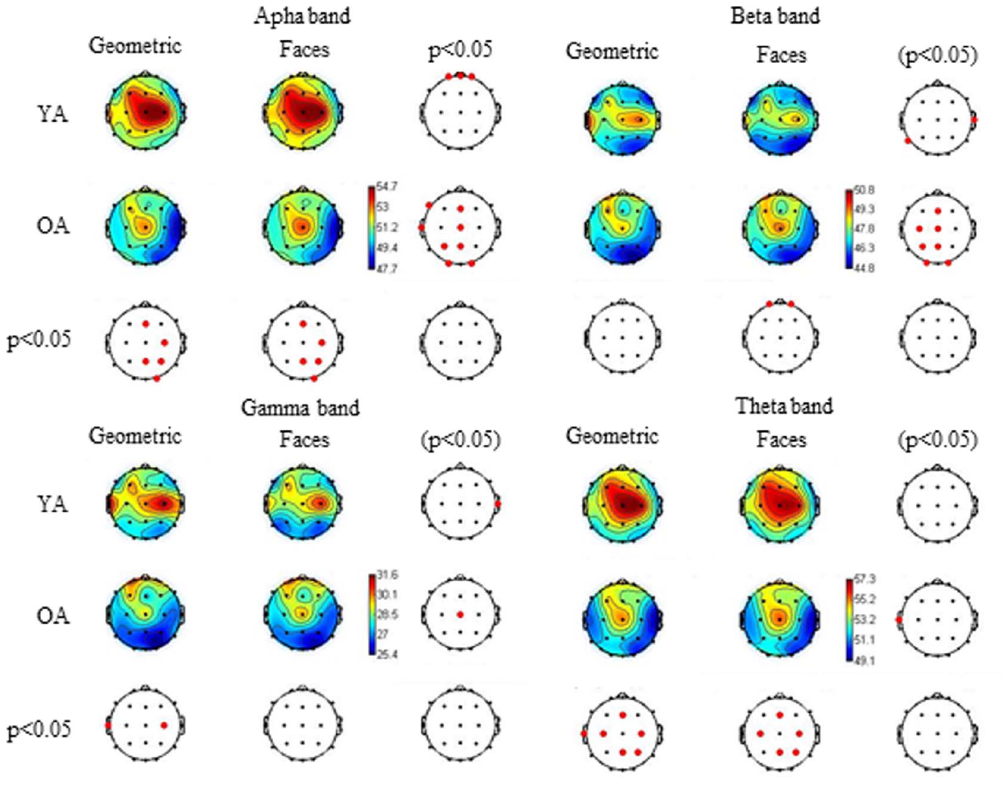
Figure 3. Relative topographic power spectrum distribution for specific bands with type of stimulus and age group. Types of stimulus are: geometric pictures and facial photos. Age groups are: young adults (YA) and older adults (OA). Alpha activity: 8 to 13 Hz, Beta activity: 13 to 30 Hz, Gamma activity: 30 to 70 Hz, Theta activity: 4 to 8 Hz. Red dots indicate significant statistical differences (p , 0.05; parametrical tests) related to age groups and to types of stimulus in electrode location.